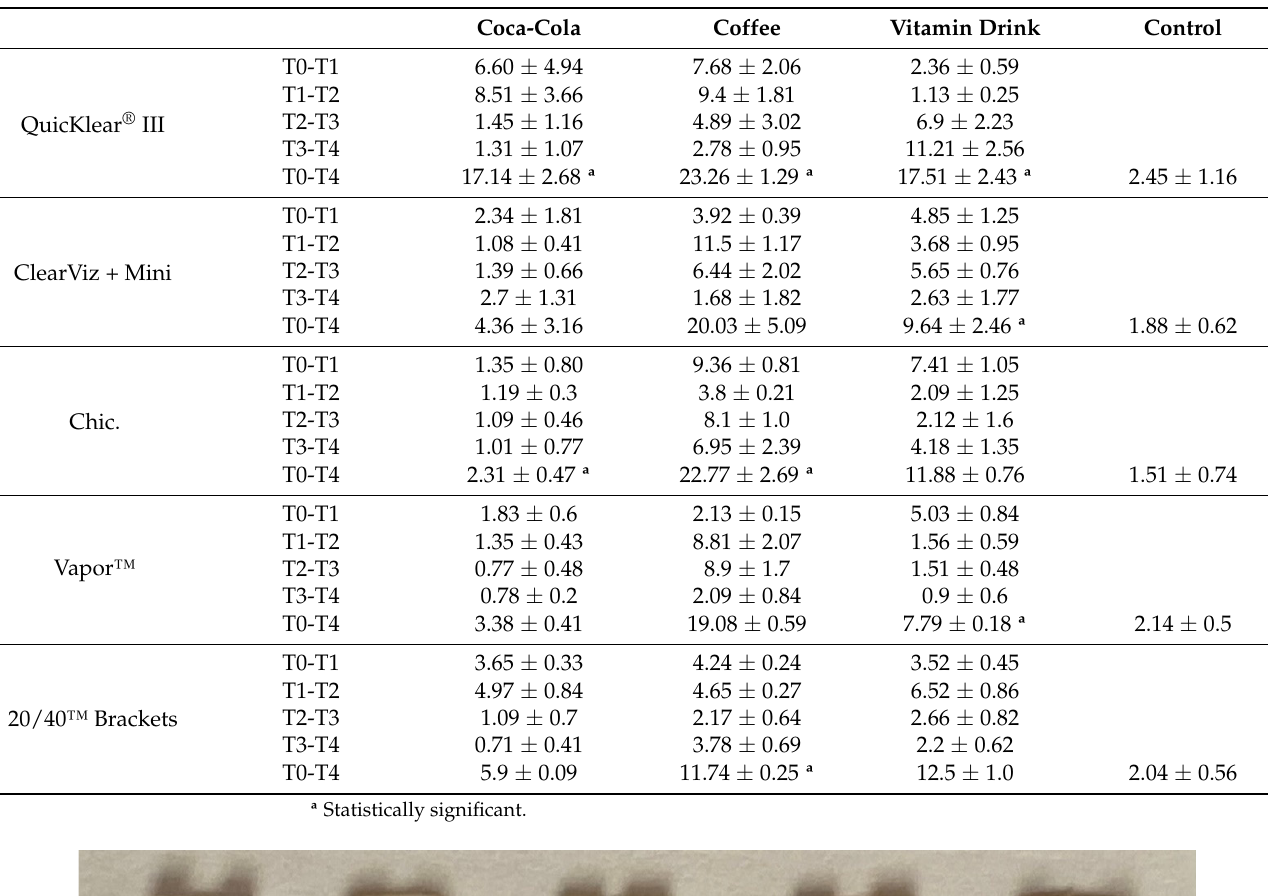
Table 2. Means and standard deviations of color change values ( ∆ E*) of ceramic brackets, according to the solution over time.